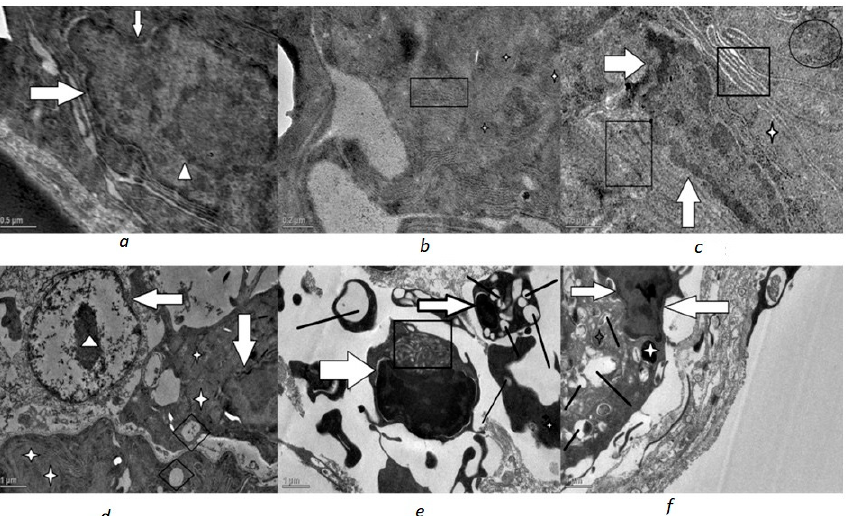
Figure 2. Transmission electron micrographs of 0.2 mg/L Phorate exposed renal cells exposed for 72 h revealing degenerative changes: ( a ) deformed nucleus (white filled arrow) and condensed heterochromatin (arrow head) (scale 0.5 µm; ( b ) degenerated endoplasmic reticulum ( □ ) and condensed degenerated mitochondria(white star) (scale 0.2 µm). ( c ) more degenerative and deformed nucleus (white arrow head), dilated and deformed ER ( □ ), increased lysosomes (circled) and deformed mitochondria (white star) (scale 0.5 µm); ( d ) deformed nucleus (white filled arrow) and electron dense condensed chromatin (white arrow head) and vacuole (boxed ◊ ) ( e ) showing severe electron dense deposits in the deformed nucleus (white filled arrow) with whorl of degenerated ER ( □ ), severe cytoplasmic vacuolation (thick black line) and deformed mitochondria (star) (scale 1 µm); ( f ) deformed nucleus (white filled arrow), degenerated mitochondria (star), severe vacuolation (thick black line) (scale 1 µm).